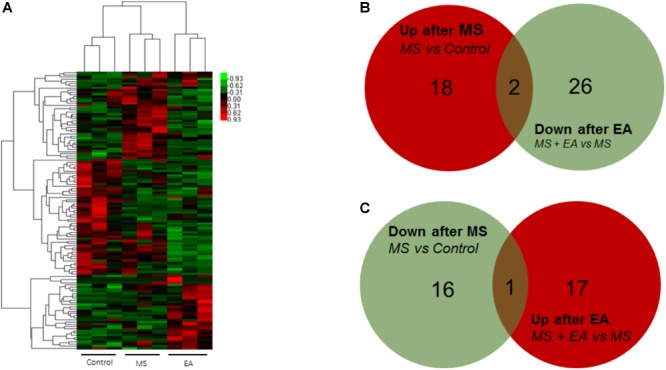
Differential circRNA expression in the prefrontal cortex of Cont, MS, and MS+EA in adult rats. (A) Heatmap of differentially expressed circRNAs between Cont, MS, and MS+EA samples (p < 0.05) with green and red spectrum colors indicating downregulated and upregulated expression, respectively. (B,C) Venn diagrams show overlaps of differentially expressed circRNAs between experimental groups. Two genes increased expression in MS group but decreased in EA group. One gene decreased expression in MS group but increased in EA group.